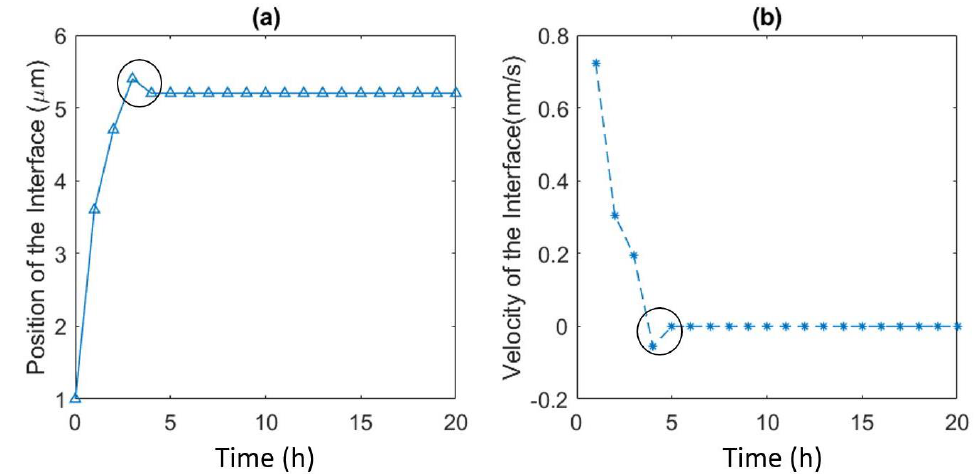
Figure 10. ( a ) Position of the interface and ( b ) Velocity of the interface. These plots show the unusual kink (encircled in the figure) after 3 h which refers to the oscillation of grain boundary for SL 2